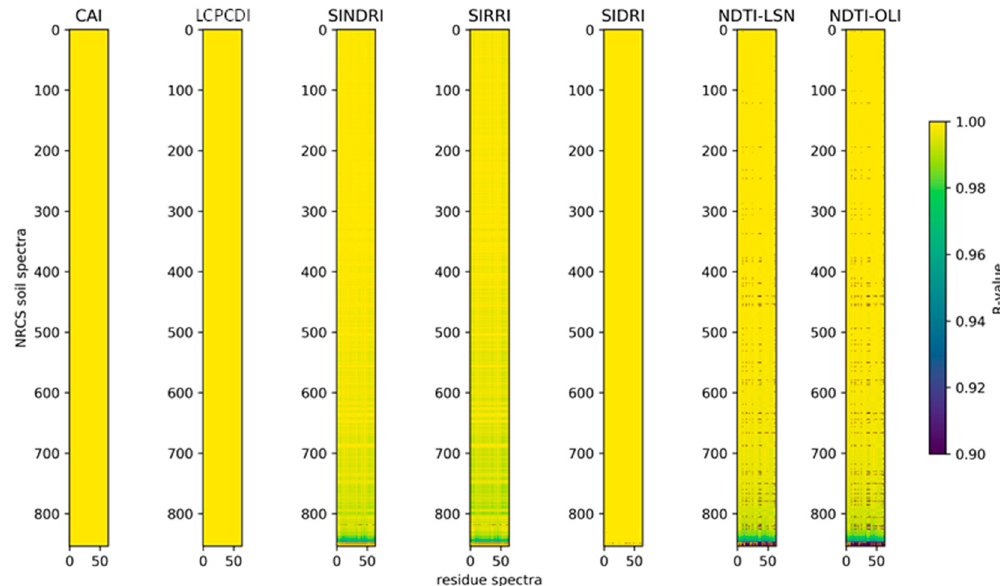
Figure 10. R-value of six select SWIR NPV indices showing that the three indices based on differences (i.e., CAI, LCPCDI, and SIDRI) have near-perfect linearity (R-value = 1.0) across all simulated soil-residue spectra combinations. In contrast, ratio and normalized difference indices (i.e., NDTI, SIRRI, SINDRI) do not show this near-perfect linearity. Note that the soil-residue spectra combinations for all indices are ordered identically based on decreasing NDTI R-values and that SINDRI and SIRRI follow similar general patterns of decreasing R-value. Values in black at the bottom of the NDTI plots indicate seven soils with negative R values. The x -axis denotes the range of 69 crop residue spectra (corn, soybean, and wheat), while the y -axis denotes the range of 854 soil spectra collected from a broad variety of soils.